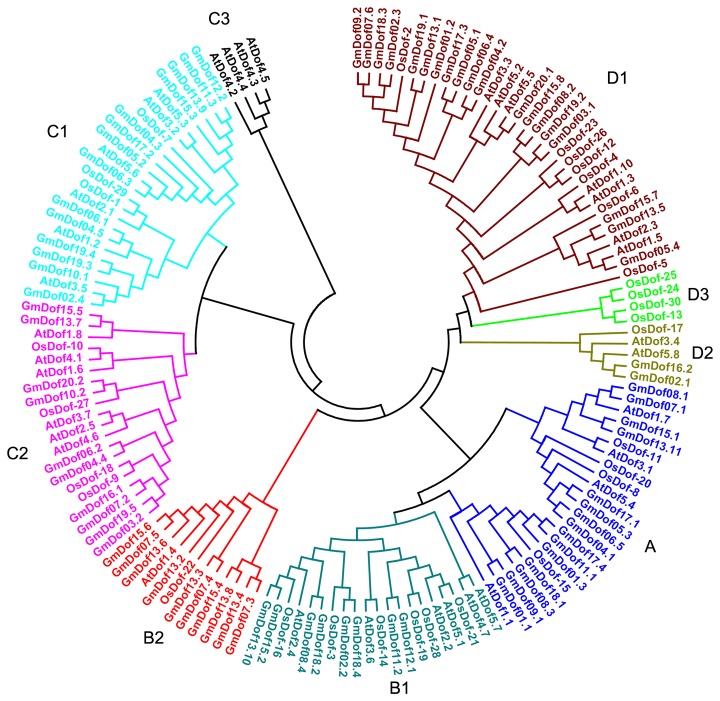
Phylogenetic tree of all Dof domain containing proteins from soybean,
Arabidopsis
, and rice.The deduced full-length amino-acid sequences of 78 soybean, 36
Arabidopsis
 and 30 rice Dof genes were aligned by Clustal X 1.83 and the phylogenetic tree was constructed using MEGA 4.0 by the neighbor-joining method with 1,000 bootstrap replicates. Each Dof subgroup is indicated by a specific color.